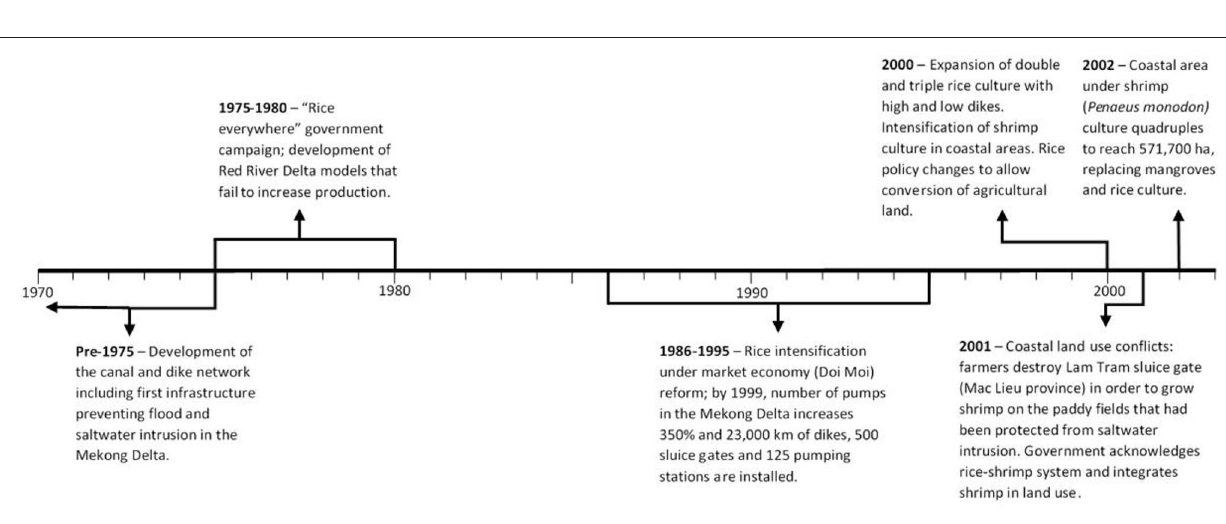
Frontiers in Sustainable Food Systems | www.frontiersin.org